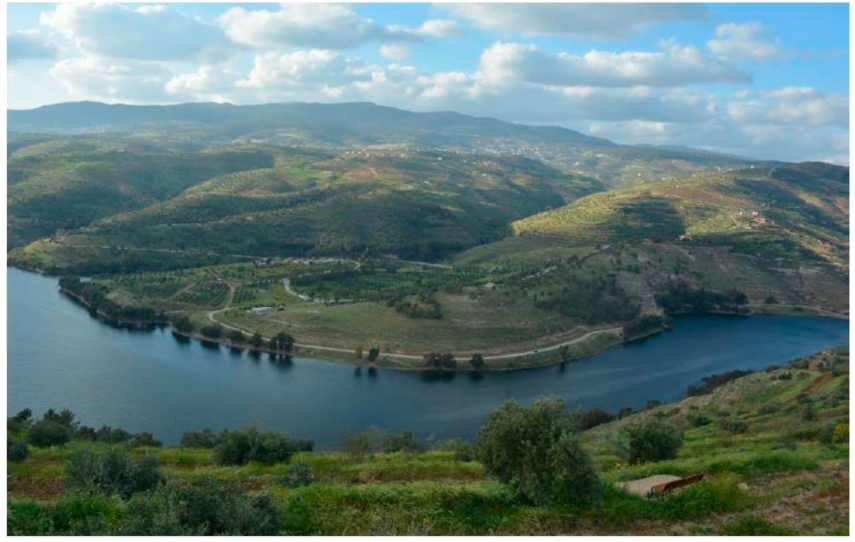
Figure 1. King Talal Dam area.